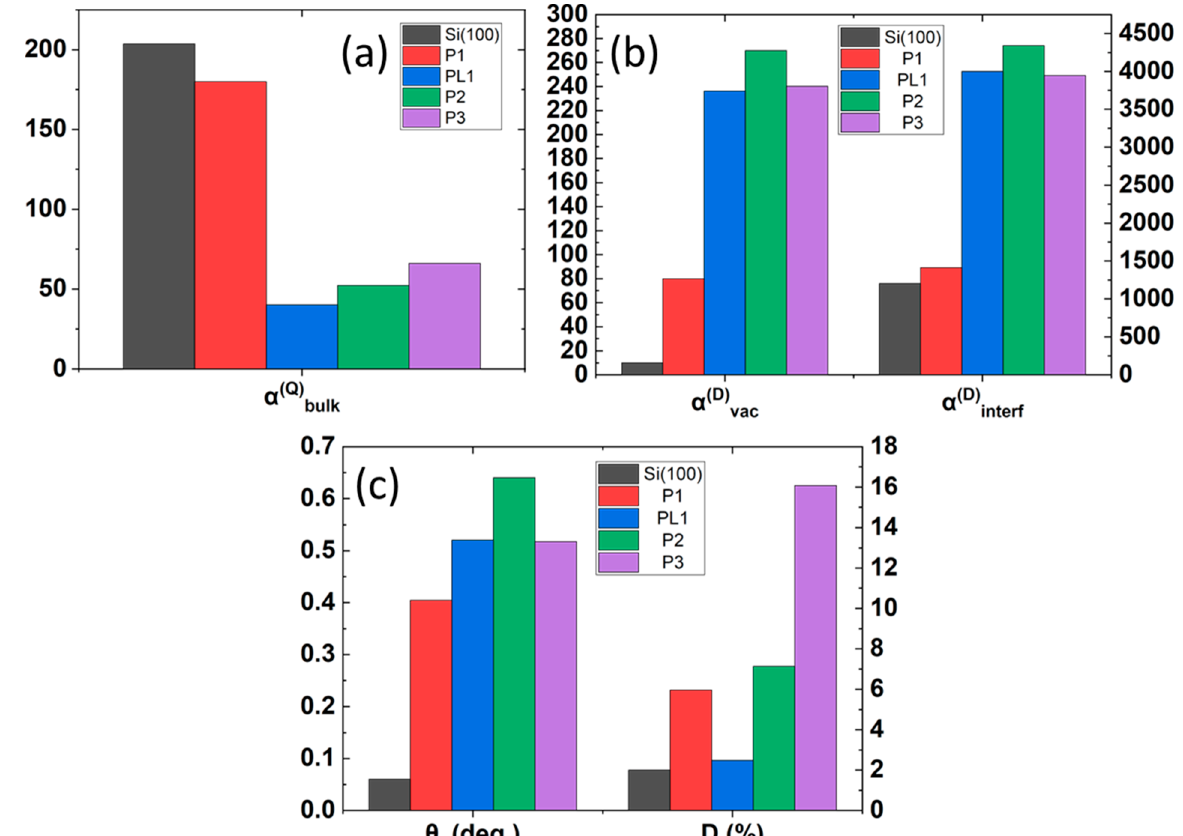
Figure 10. Fitted the SBHM parameters of the P-doped Si(100) Ani-RSHG spectrum. Fitted parameters include the effective hyperpolarizabilities of ( a ) bulk quadrupolar, α , ( b ) vacancy dipolar, α vac , and interface dipolar, α , SHG, ( c ) the lattice tilt angle, θ t , and the deformation ratio, D